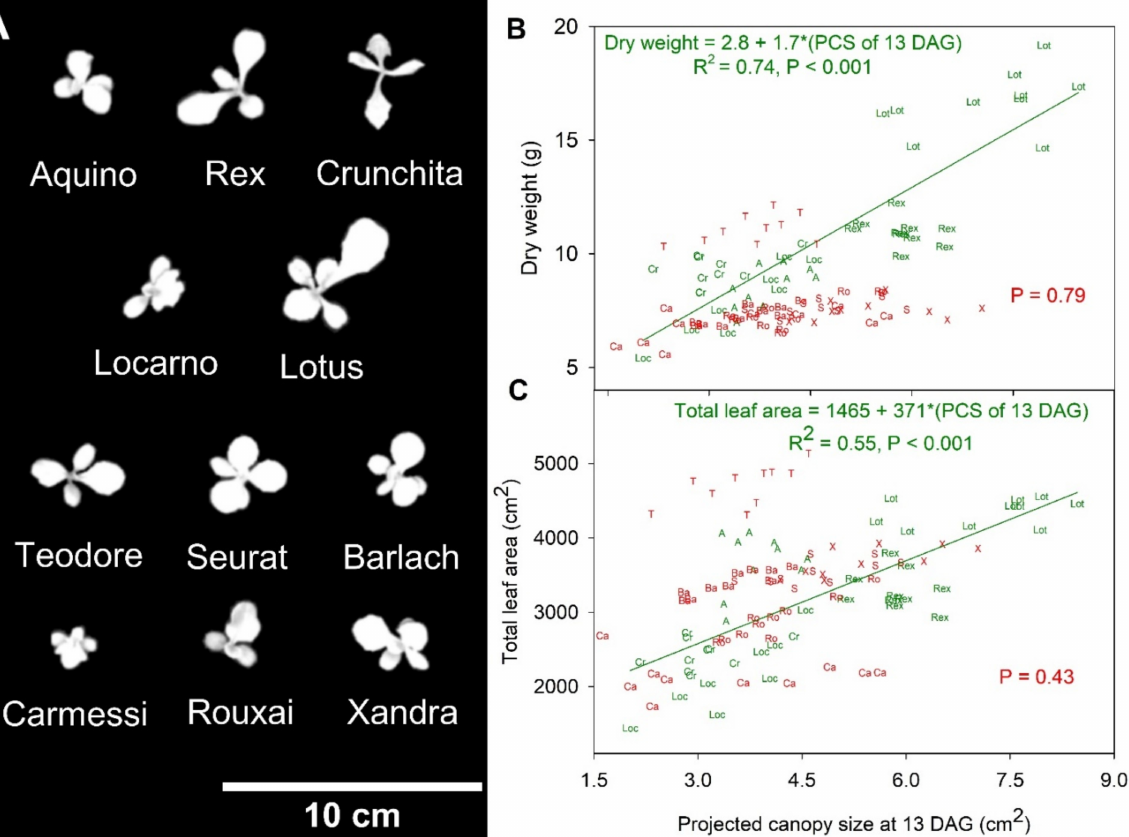
Figure 4. ( A ) Representative canopy images of lettuce cultivars at 13 days after germination (DAG); ( B ) Regression analysis between projected canopy size (PCS) at 13 DAG and shoot dry weight at harvest; ( C ) Regression analysis between PCS at 13 DAG and final total leaf area. The plots show summaries of significant regressions or only p -value when there was no significance ( p = 0.05). Letters in Figures ( B , C ) correspond to cultivars names (‘Aquino’ (A), ‘Barlach’ (Ba), ‘Carmessi’ (Ca), ‘Crunchita’ (Cr), ‘Locarno’ (Loc), ‘Lotus’ (Lot), ‘Rex’ (Rex), ‘Rouxai’ (Ro), ‘Seurat’ (S), ‘Teodore’ (T), and ‘Xandra’ (X)), while red and green colors refer to red and green lettuce cultivars and their respective regression